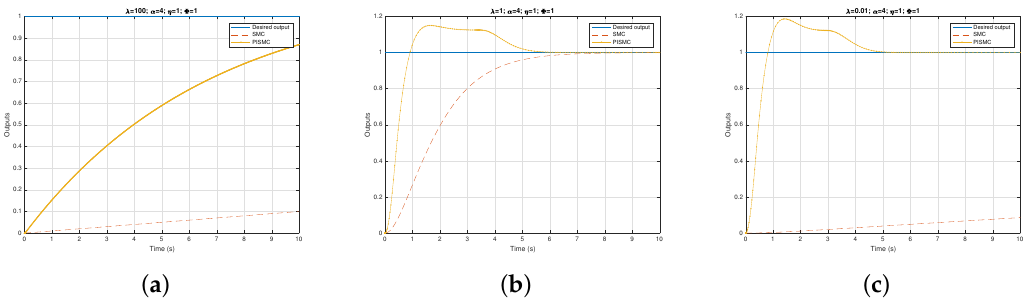
Figure 4. Comparison of parameter effectiveness. ( a ) λ = 100; ( b ) λ = 1; ( c ) λ =